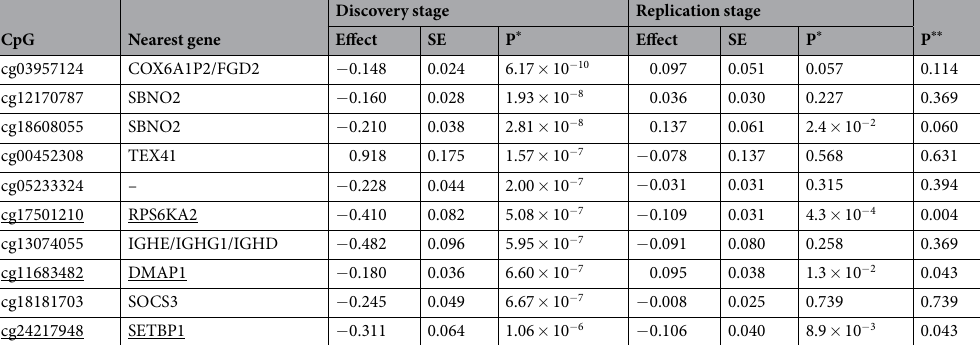
Table 3. Differentially methylated CpG sites in a replication sample consisting of BMI discordant monozygotic twins. * Unadjusted P-values. ** Benjamini-Hochberg adjusted P-values. Significant differential CpG sites using an FDR of 5% are